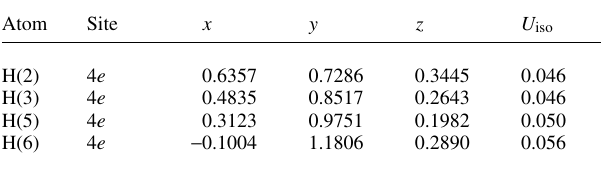
Table 2. Atomic coordinates and displacement parameters (in Å 2 )